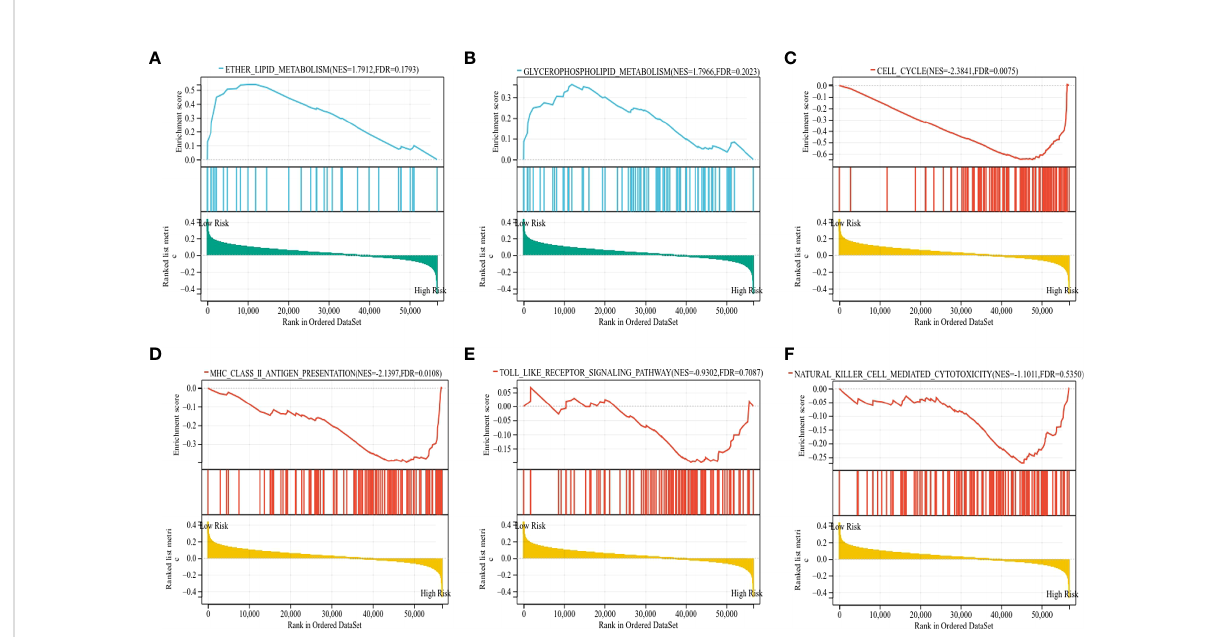
FIGURE 9 The KEGG signaling pathways enriched by GSEA. (A, B) The signaling pathways of ether lipid metabolism and glycerophospholipid metabolism were mainly enriched in the low-risk group. (C – F) The signaling pathways of the cell cycle, MHC class II antigen presentation, Toll-like receptor, and natural killer cell-mediated cytotoxicity were mainly enriched in the high-risk